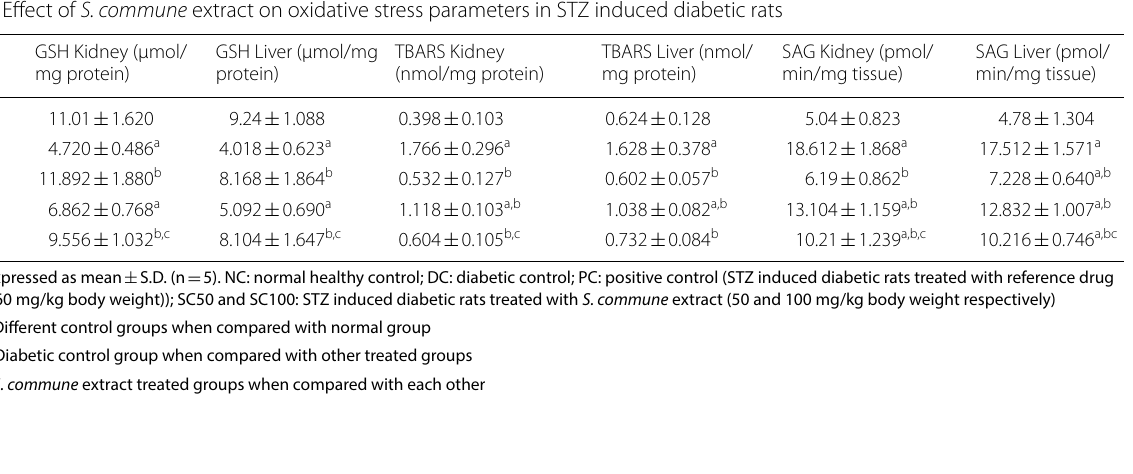
Table 3 Effect of S. commune extract on oxidative stress parameters in STZ induced diabetic rats